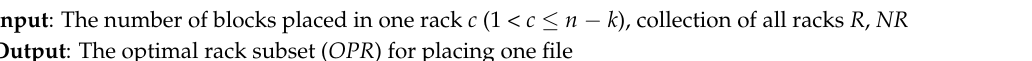
Algorithm 2 An algorithm for load balancing